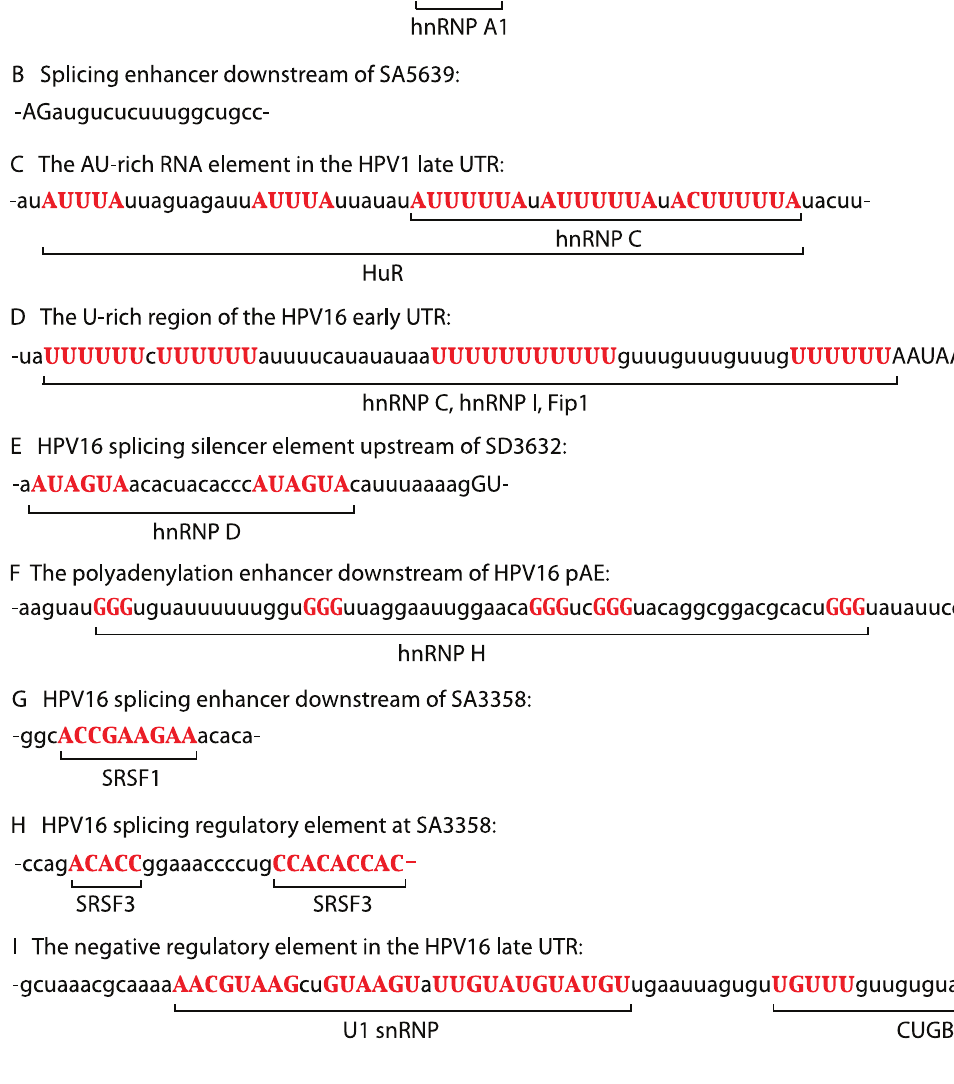
Figure 2. Sequences of cis -acting RNA elements on the HPV1 or HPV16 genome. Binding sites for cellular factors are capitalized and in red. See text for details. ( A ) Splicing silencer downstream of SA5639. ( B ) Splicing enhancer downstream of SA5639. ( C ) The AU-rich RNA element in the HPV1 late UTR. ( D ) The U-rich region of the HPV16 early UTR. ( E ) HPV16 splicing silencer element upstream of SD3632. ( F ) The polyadenylation enhancer downstream of HPV16 pAE. ( G ) HPV16 splicing enhancer downstream of SA3358. ( H ) HPV16 splicing regulatory element at SA3358. ( I ) The negative regulatory element in the HPV16 late